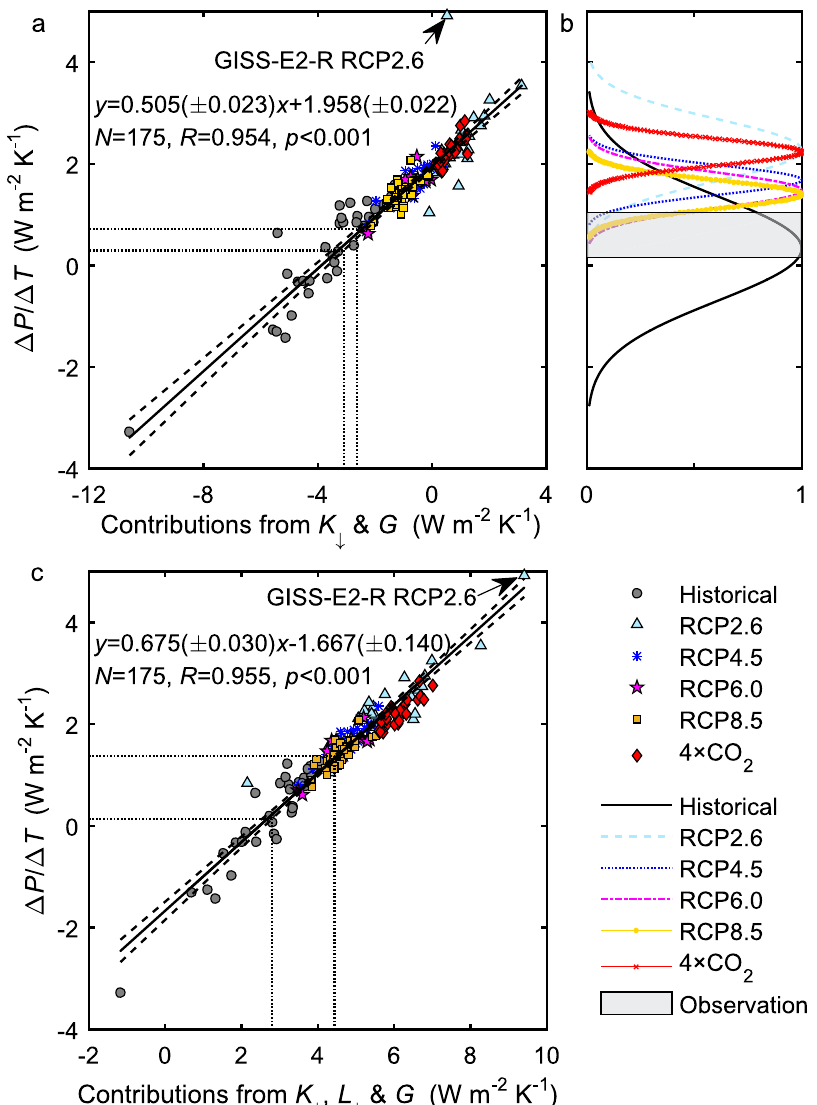
Fig. 4 Emergent constraint on global precipitation temperature sensitivity. a Control of surface incoming shortwave radiation ( K ↓ ) and ocean heat storage ( G ) on the spread of climate model simulations of precipitation temperature sensitivity ( Δ P / Δ T ). The x axis is the combined contribution from changes in K ↓ and G , as ð 1 (cid:2) a Þ = ð 1 þ β Þð Δ K # = Δ T Þ (cid:2) 1 = ð 1 þ β Þð Δ G = Δ T Þ . Solid line represents the best fi t with the regression statistics noted. (The outlier is excluded from the regression.) Dashed lines are the 95% con fi dence bounds. The two vertical and horizontal parallel lines indicate the observational constraint. b Gaussian probability distribution of precipitation temperature sensitivity. The gray horizontal bar denotes the observational range (mean ± one standard deviation). c Same as a except that the surface incoming longwave radiation ( L ↓ ) is included as a controlling variable, as